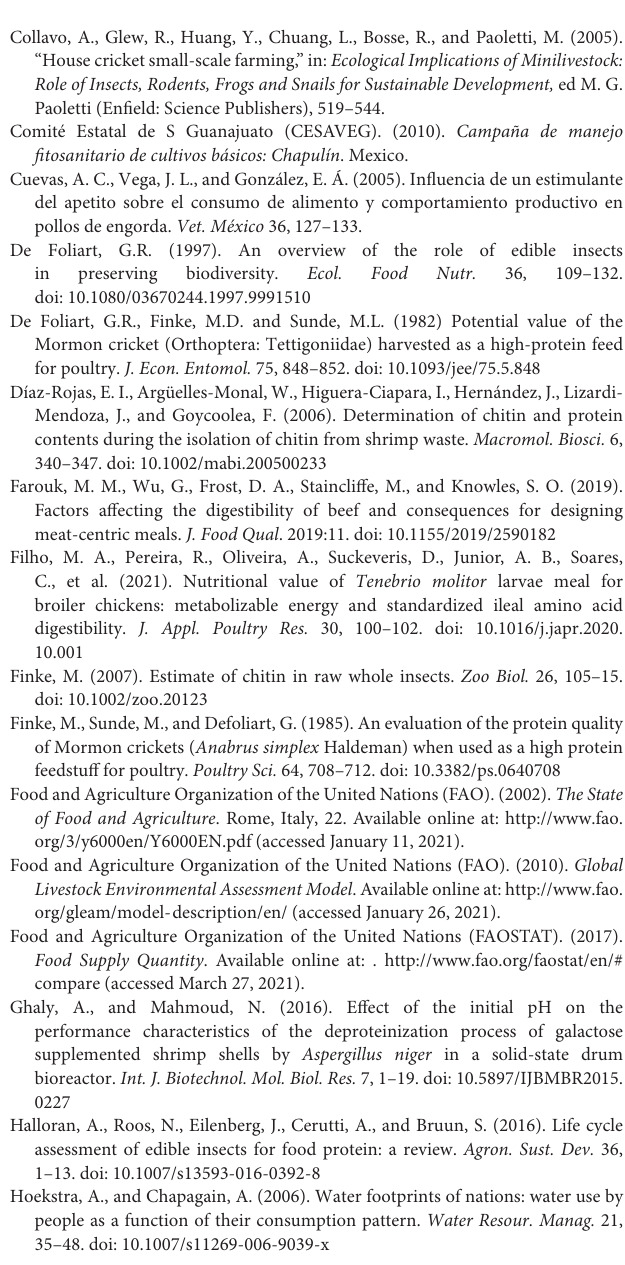
Supplementary Figure 1 | Calculation of the food conversion ratio for each diet (CT, Control; SP, Standard protein; LP, Hypoproteic; HP, Hyperproteic; FF, Hypercaloric) at the end of the